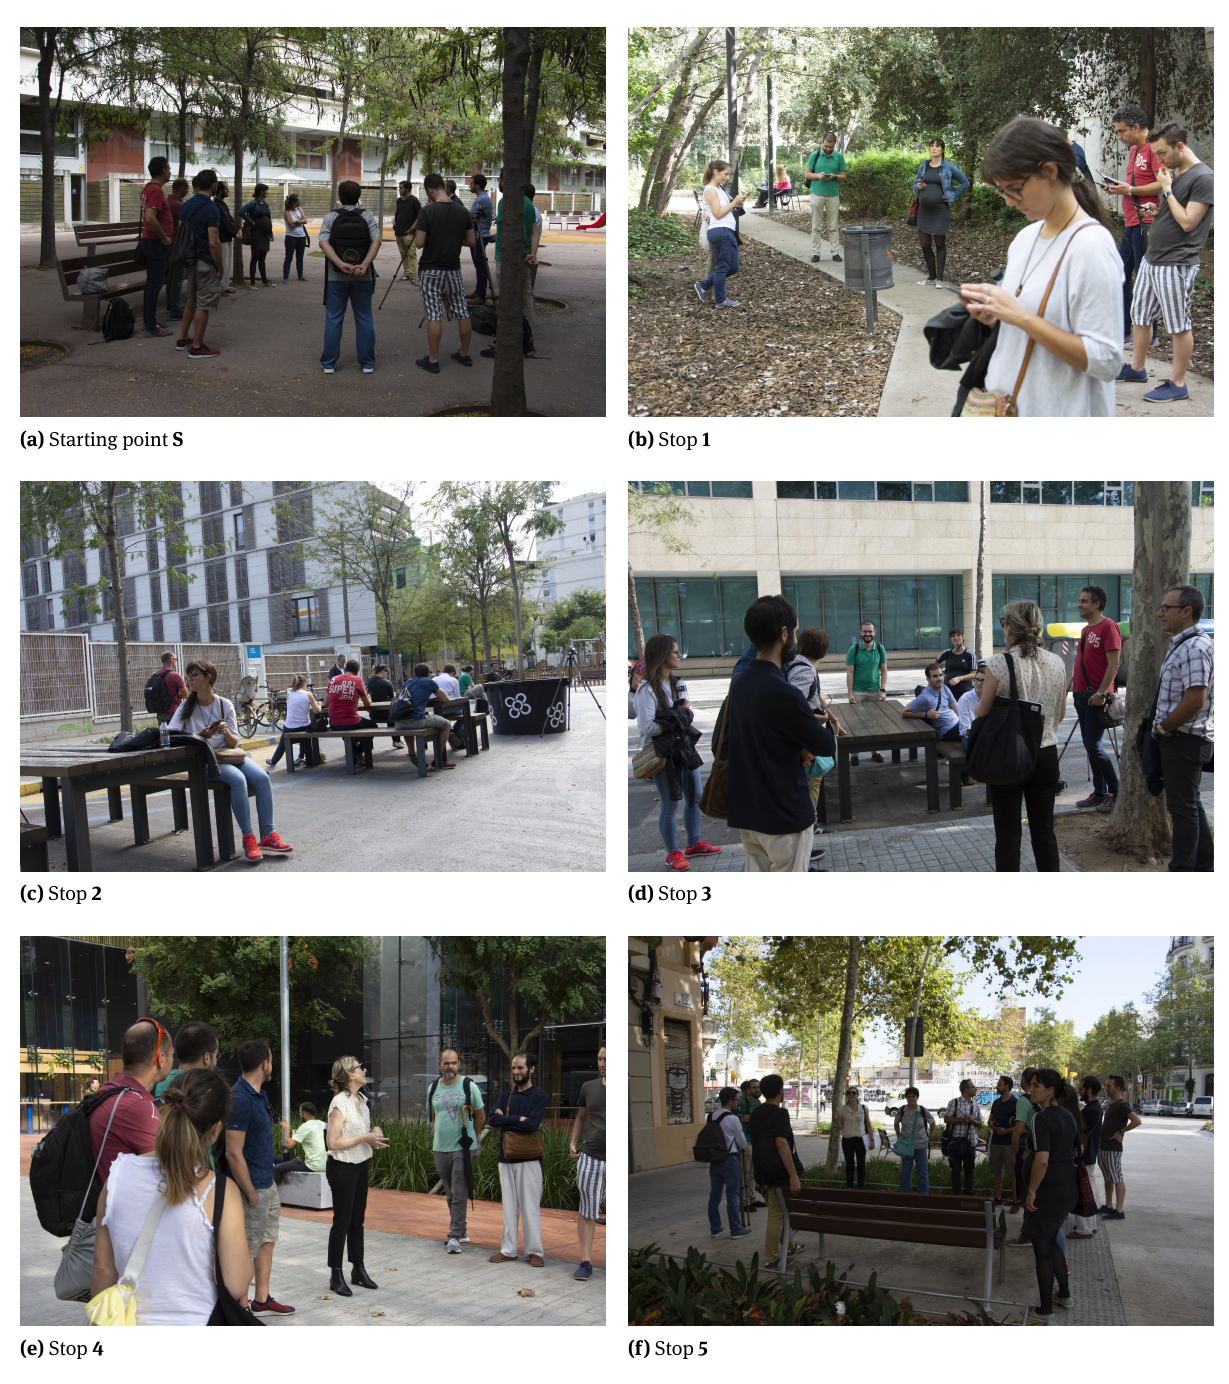
Figure 2: Picture of the participants of the soundwalk in the different listening points (©pictures by La Salle